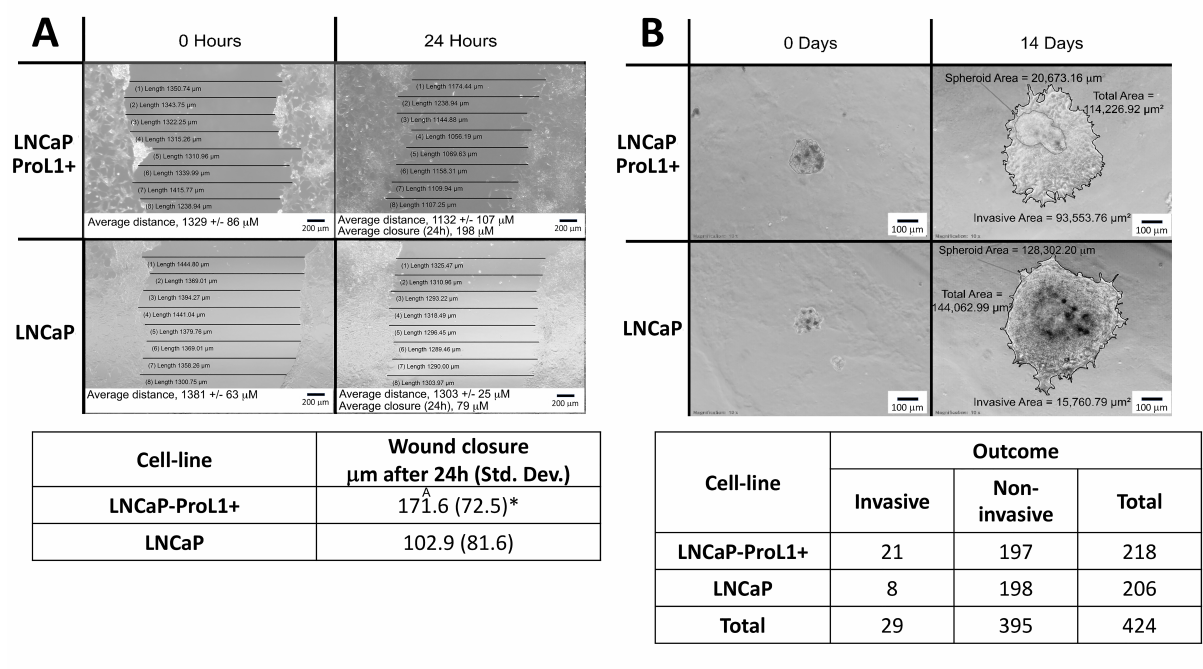
Fig. 1. Overexpression of PROL1 in LNCaP cells results in a more invasive phenotype. (A) A representative wound healing assay for LNCaP-ProL1+ and LNCaP cells is shown (upper panel). The width of the wound was measured at at least eight points per image. Data shown (lower panel) represents the mean rate of wound healing ( µ m per 24 hours) ± Std. Dev. of five independent experiments (with measurements performed in triplicate for each experiment). * = p -value < 0.001. (B) A representative 3D spheroid invasion assay for LNCaP-ProL1+ and LNCaP cells is shown (upper panel). Spheroids were determined to be invasive if a 2D layer of cells was observed growing around the spheroid. Data shown (lower panel) represents the total number of invasive and non-invasive spheroids formed by LNCaP-ProL1+ and LNCaP after 2-weeks. LNCaP-ProL1+ cells generated significantly higher invasive according to the Fisher’s exact test ( p <